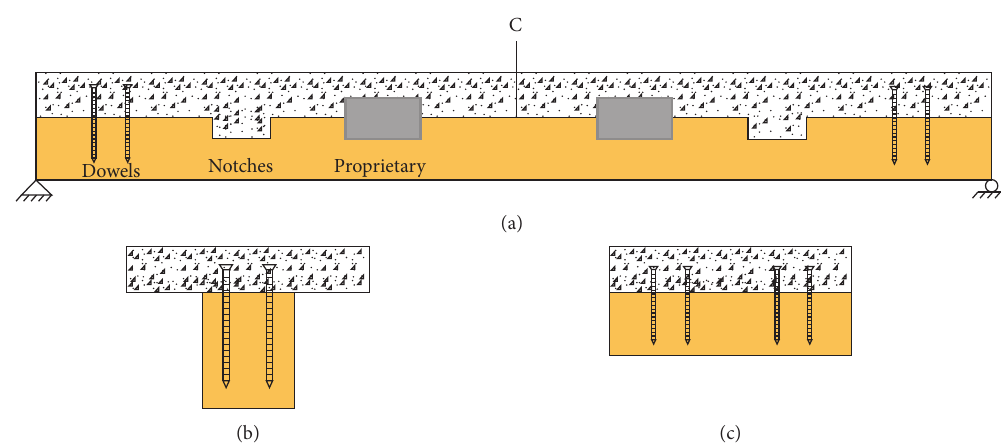
Figure 1: (a) Longitudinal section of a TCC system with dowel, notched, or proprietary connectors; cross section of a TCC floor (b) with timber beam and (c) with